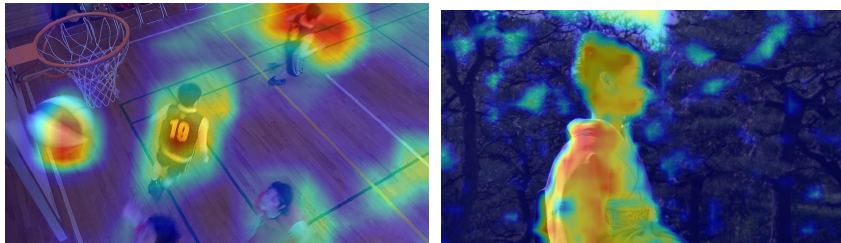
Figure 1. The grad-CAM heat-map results.